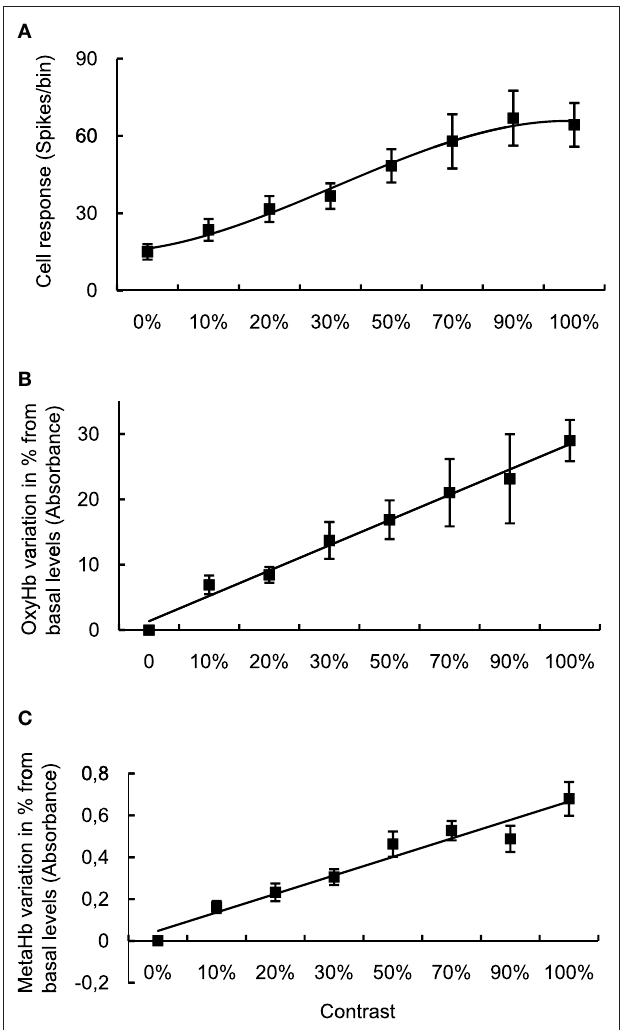
FIGURE 2 | Relationship between metabolic and neuronal responses with stimulus intensity. (A) Contrast response curve obtained varying the contrast from 0% (background cell activity) to 100% versus neuronal response. OxyHb (B) and MetHb (C) levels obtained versus different values of contrast. All data points are average population data.